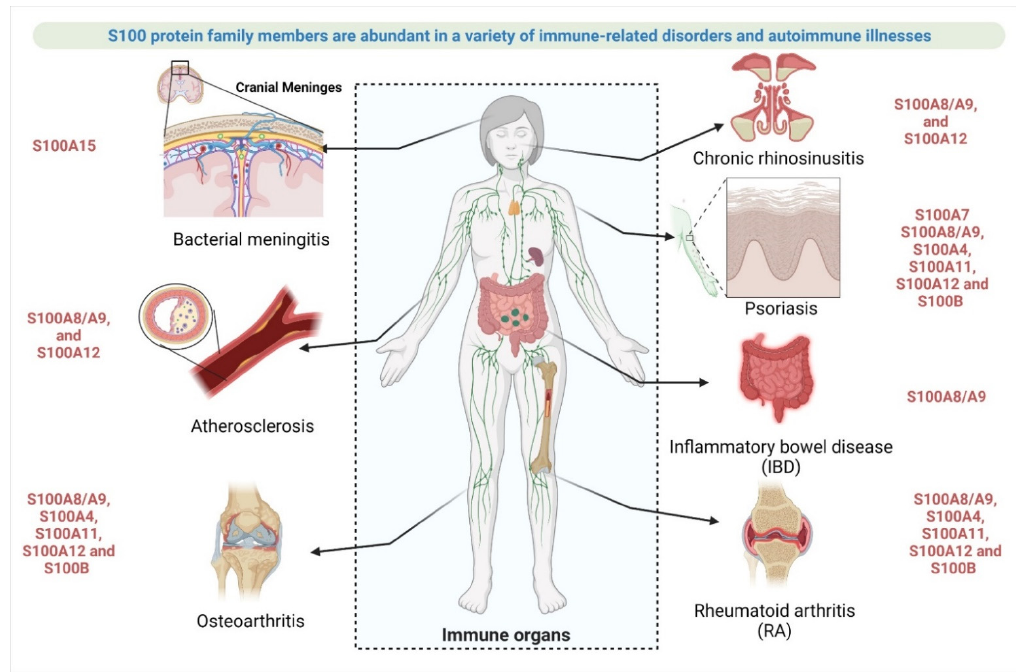
Figure 6. Detailing the role of an S100 protein family member in a variety of immune-related disorders and autoimmune illnesses, in which S100 proteins are abundantly expressed. Created with BioRender.com.